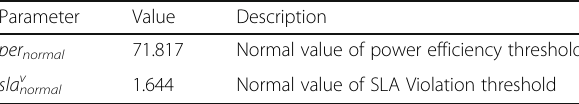
Table 5 The best values of ESDR parameters Parameter Value